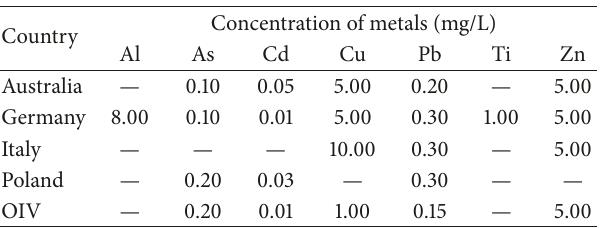
Table 6: The accepted limits of the metals content (mg/L) in wine in different countries and given by